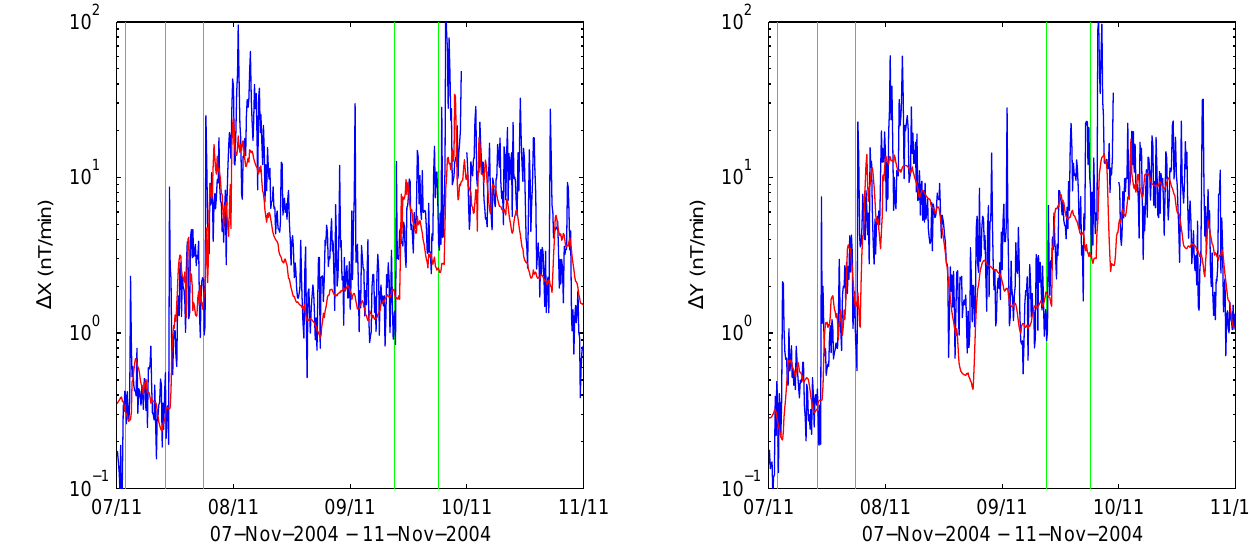
Fig. 2. The figure shows the observed (blue) and predicted (red) 10-min RMS 1X .